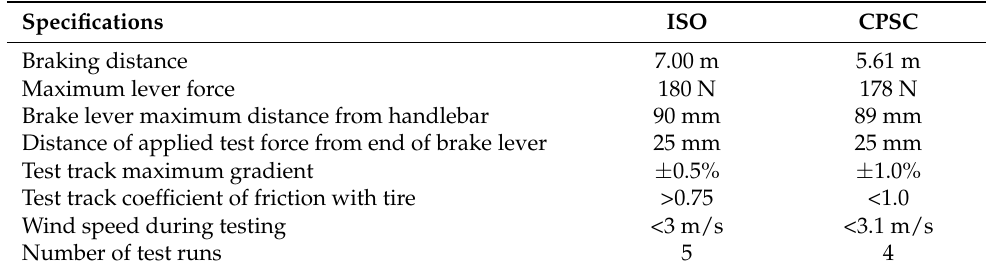
Table 1. Comparison of ISO and CPSC tests. Values for the ISO column are requirements for city bicycles in dry conditions. The CPSC braking distance has been corrected to match the ISO 25 km/h velocity and 100 kg mass